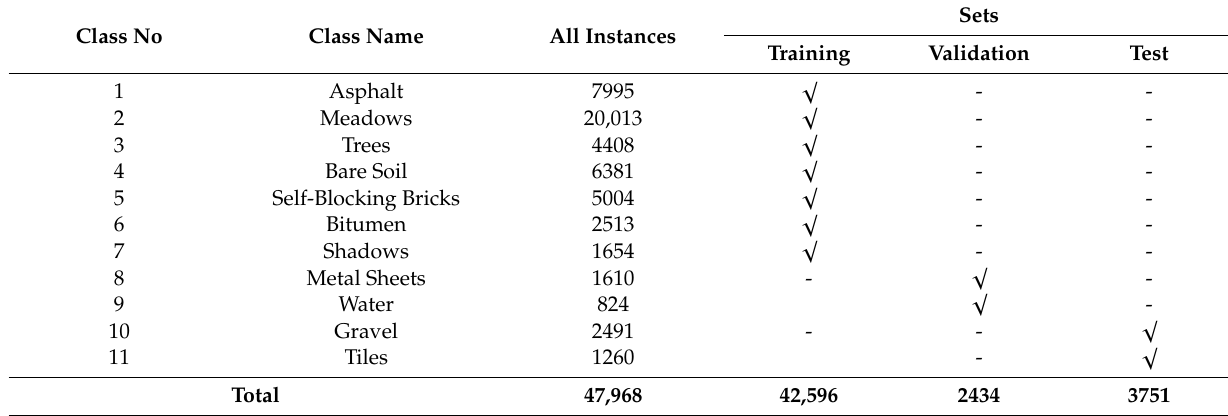
Table 7. The general Pavia